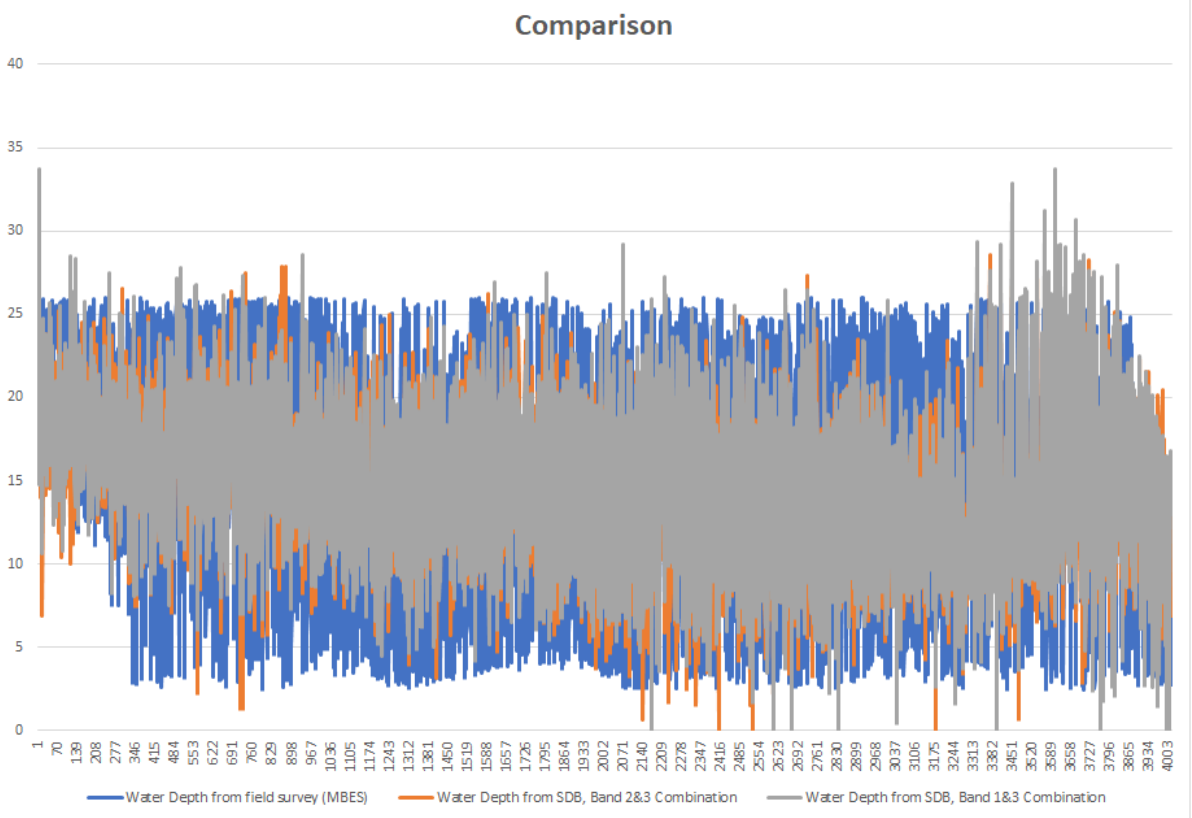
Figure 5 . Comparison between Water Depth Estimation Result from SDB and Field